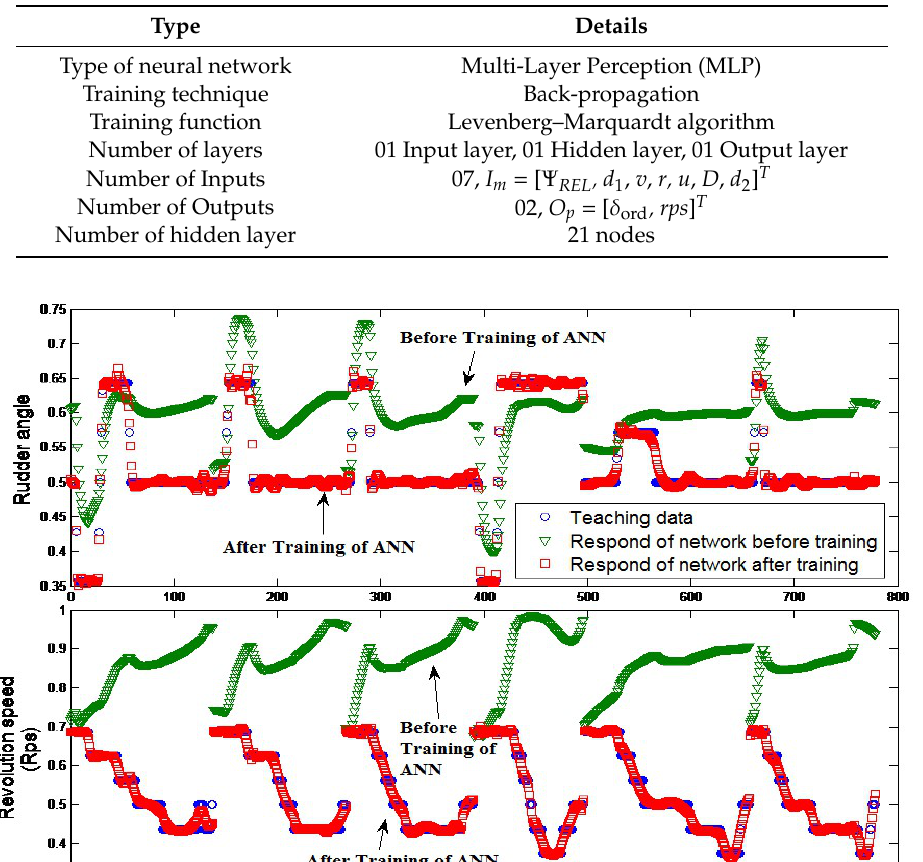
Table 3. The parameters of the structure of the neural network.